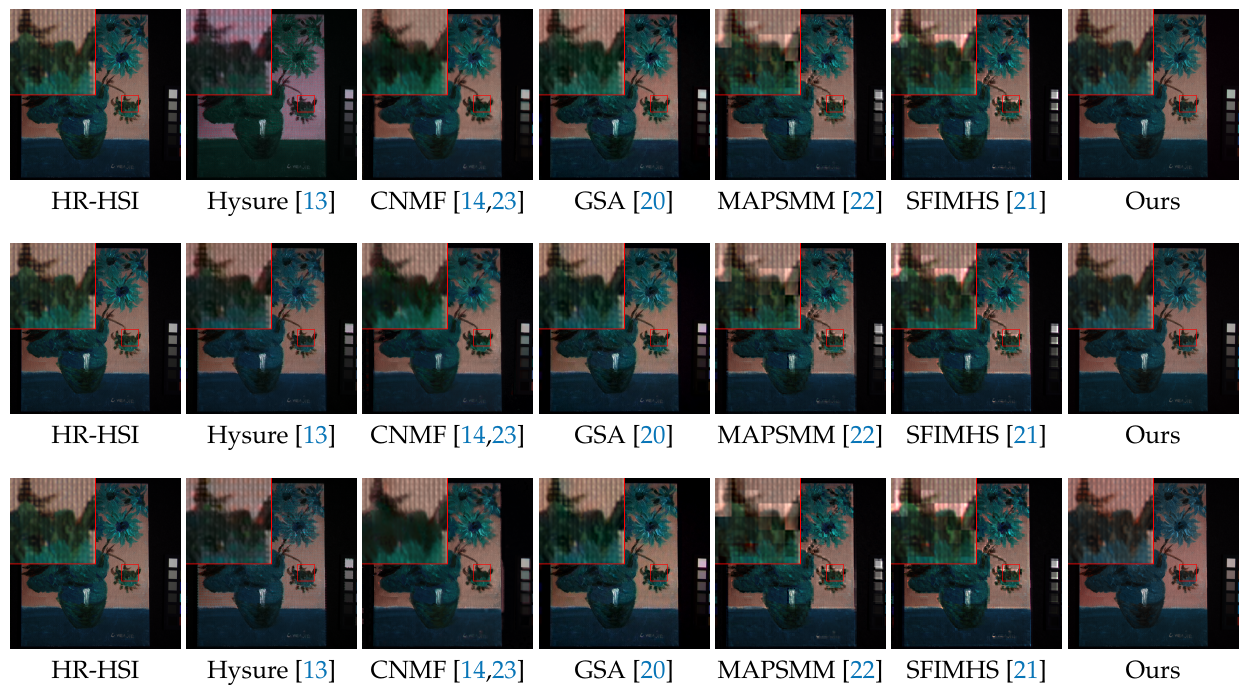
Figure 3. Fusion results for oil_painting in the CAVE dataset (formed by bands 10th, 19th, and 28th). First row, SRF1,PSF1 case, fusion image of the comparison method; Second row, SRF2,PSF1 case, fusion image of the comparison method;Third row, SRF2,PSF2 case, fusion image of the comparison method